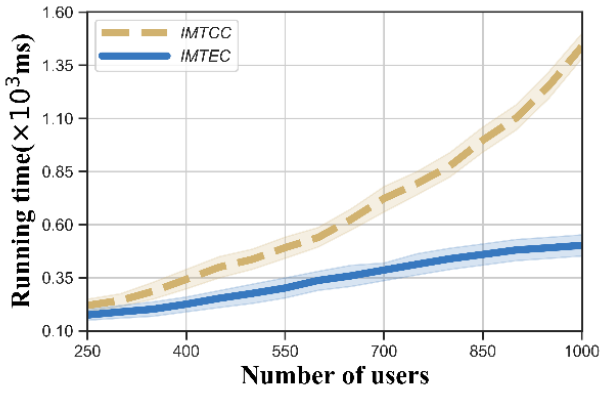
Figure 5. Running time versus number of users.